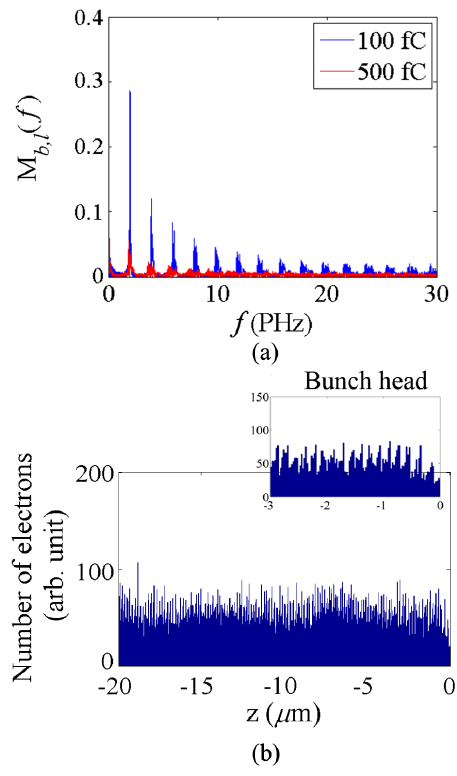
FIG. 9. (a) Longitudinal bunching spectra of simulated output beams with total charges of 100 and 500 fC at z ¼ 23 m. (b) Longitudinal distribution of a 500-fC structured hollow beam at z ¼ 23 m. Space charge fields in the 500-fC beam degrade the bunching quality. The subplot shows nevertheless a visible periodical modulation on the electron density at the bunch